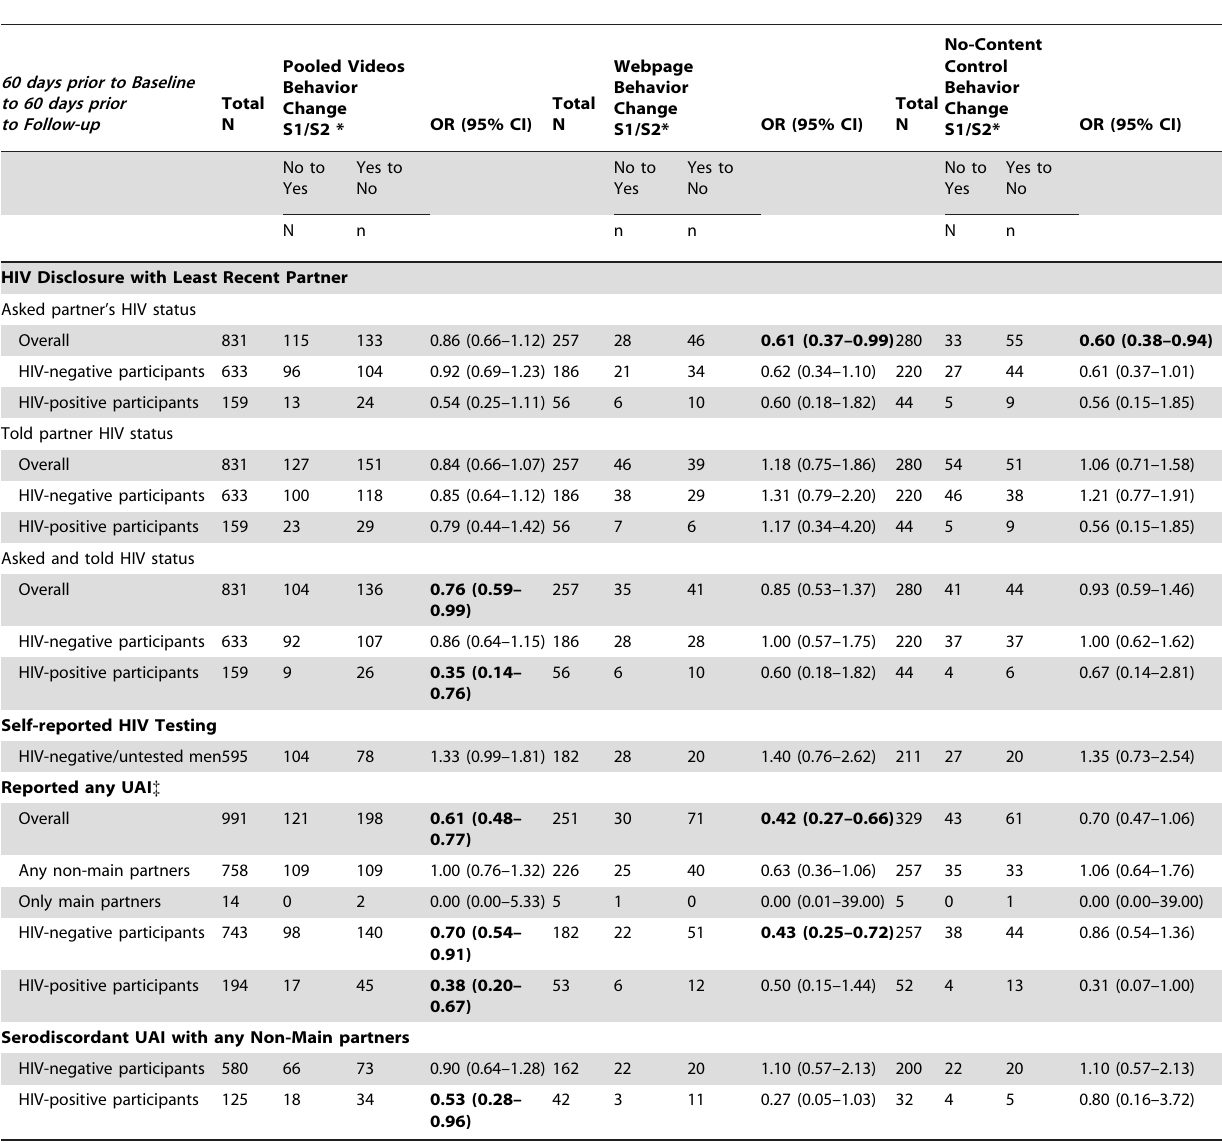
Table 4. McNemar’s Post Hoc Tests for Primary Outcomes: Baseline to 60-Day Follow-up Behaviors.